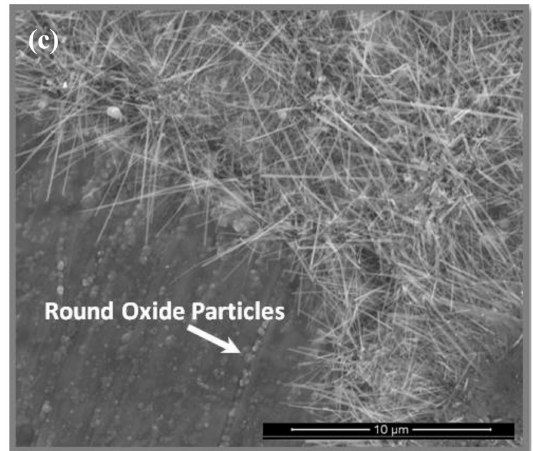
Figure 5. Images of scale surface of the alloy OHS1 after isothermal oxidation in air at 800 ◦ C: ( a ) secondary electron (SE) image, ( b ) BSE image of the same region, and ( c ) SE image at higher